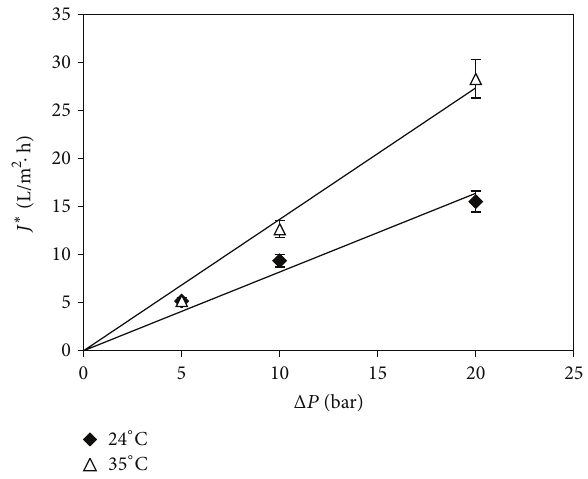
Figure 4: Effect of transmembrane pressure on permeate flux ( 𝐽 ∗ ) to 24 and 35 ∘ C.